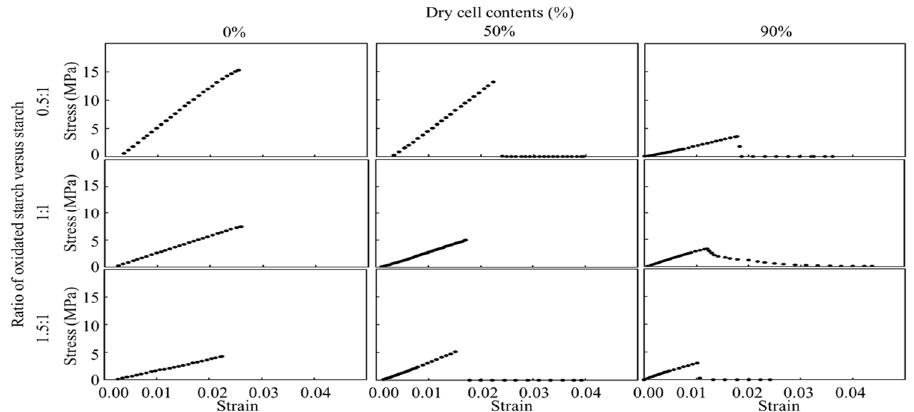
Figure 3. Analysis of stress–strain curves for each starch cell-plastic.